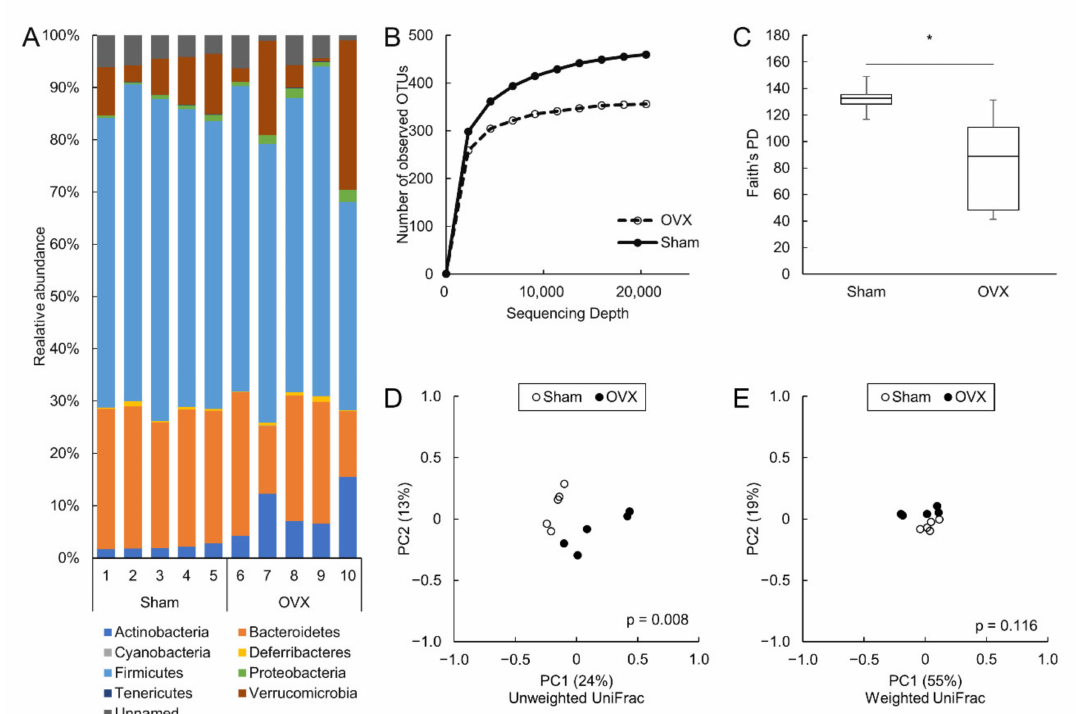
Figure 2. Dysbiosis in colon induced by ovariectomy. ( A ): Colonic microbial composition at the phylum level. ( B , C ): Alpha diversity analysis of the colonic microbiota. Rarefaction curve using the number of observed operational taxonomic units ( B ) and Faith’s phylogenetic diversity ( C ). ( D , E ): Beta diversity analysis of colonic microbiota Unweighted UniFrac ( D ) and weighted UniFrac ( E ). N = 5 per group. OTU: operational taxonomic unit, PD: phylogenetic diversity. * p < 0.05.